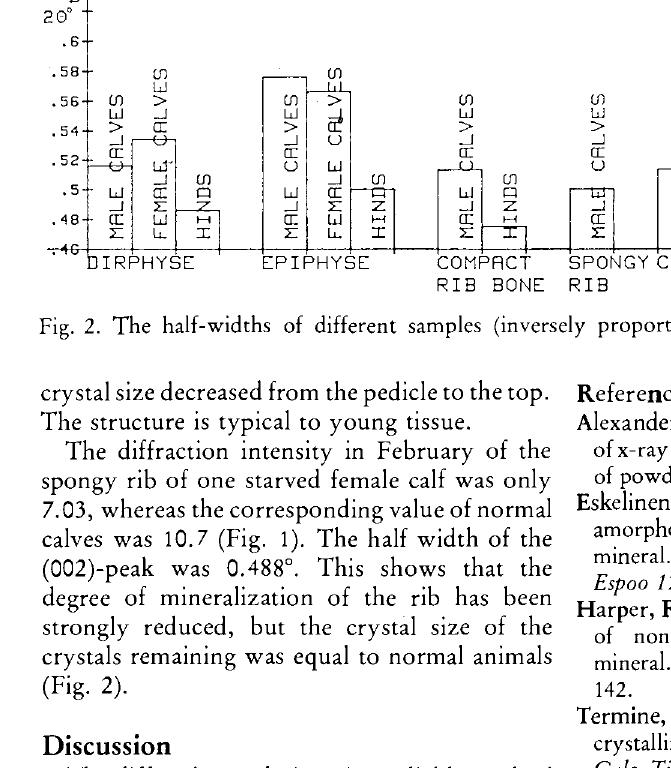
crystal size decreased from the pedicle to the